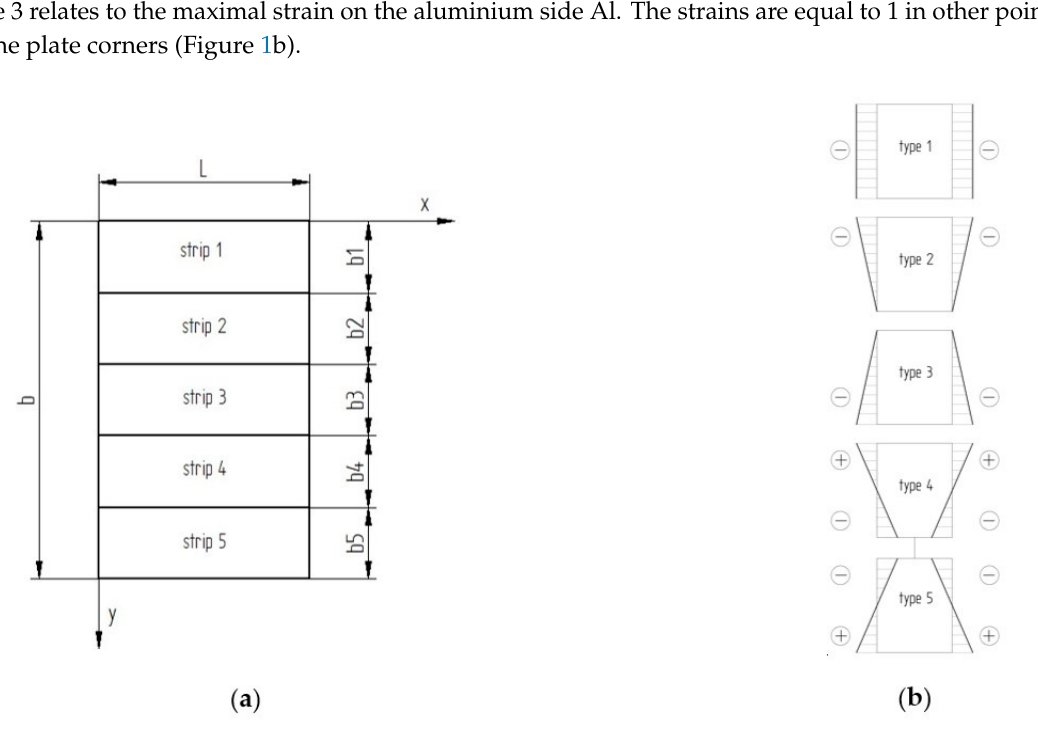
Figure 1. In-plane functionally graded (FG) rectangular plate with coordinate system ( a ) and types of assumed loads ( b